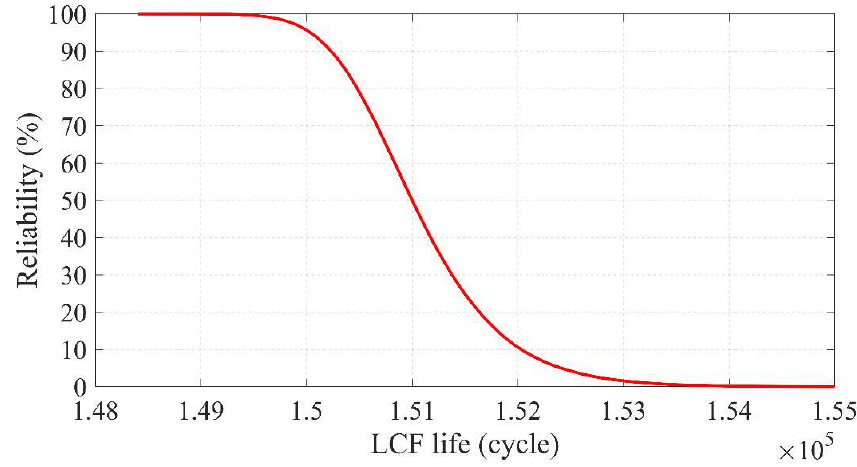
Figure 15. The reliability–life curve of the GH720Li turbine disk.